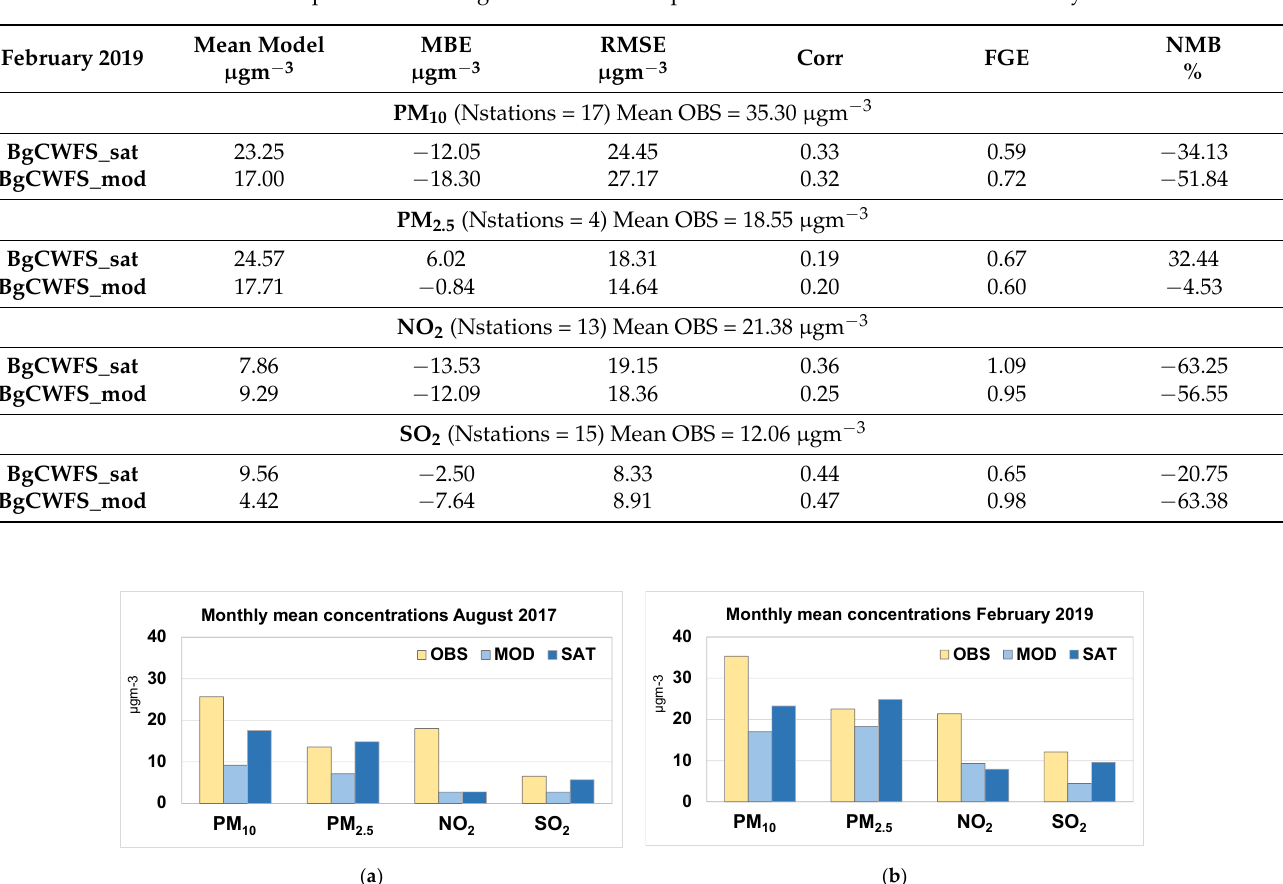
Table 2. Statistical parameters for BgCWFS results compared to surface observations in February 2019.